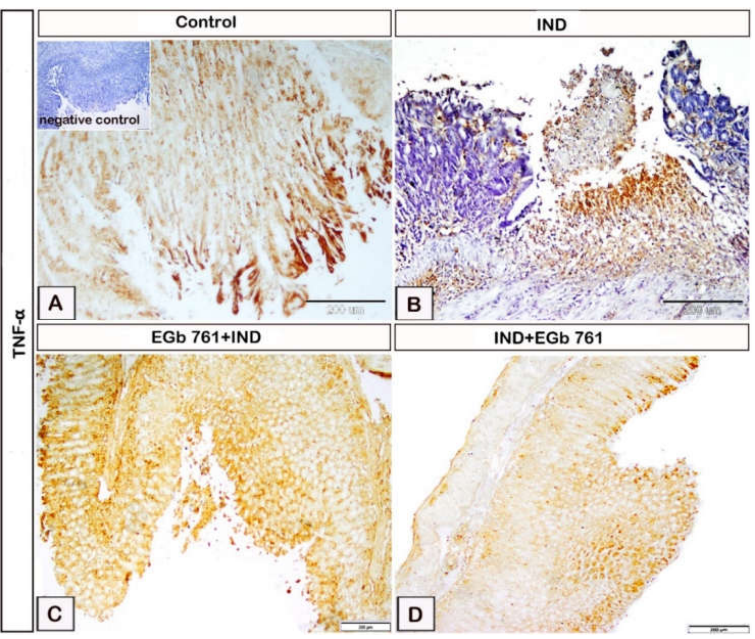
Figure 7. The changes in gastric TNF-α expression during indomethacin and EGb 761 administration were illustrated in photomicrograph immunohistochemistry of gastric mucosal samples. ( A ): Control mice. ( B ): Indomethacin-induced ulcer (IND). ( C ): EGb 761 +IND (Prophylactic EGb 761). ( D ): IND+EGb 761 (Therapeutic EGb 761). Negative marker control is shown in the inset of Figure 7A. IND: Indomethacin; EGb 761: Standardized G. biloba extract; TNF-α: Tumor necrosis factor-alpha.